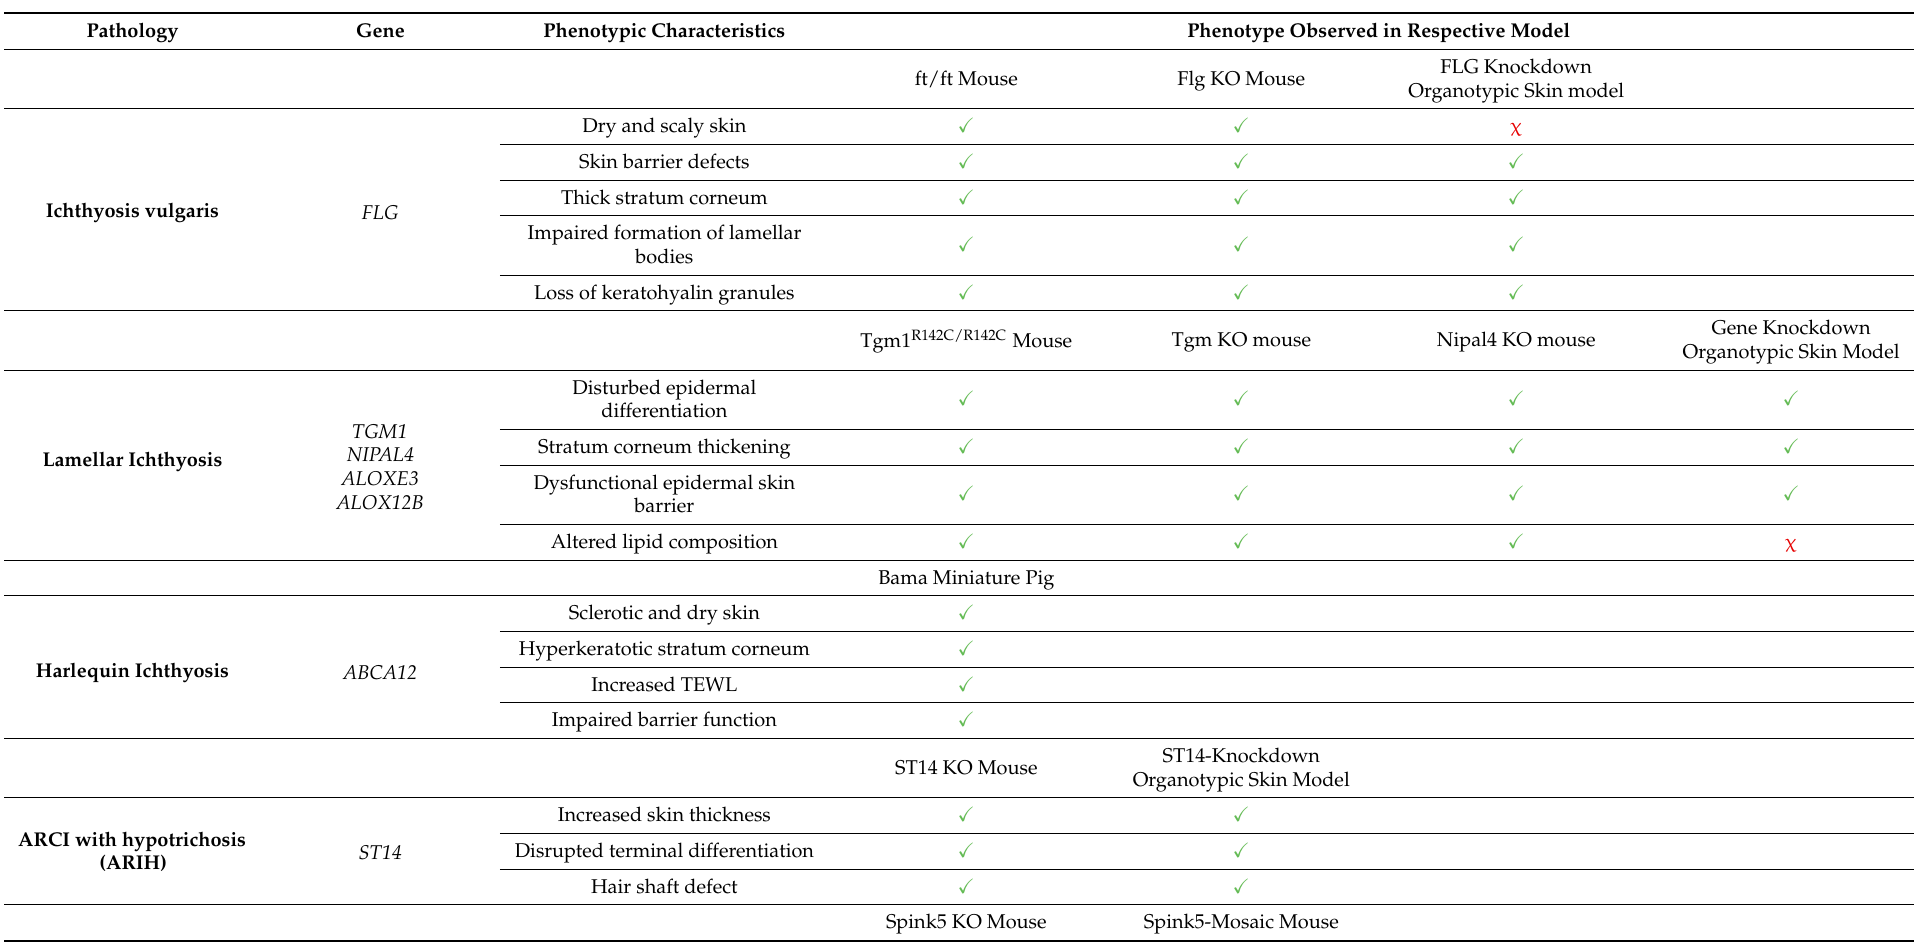
Table 1. Summary of the presented experimental